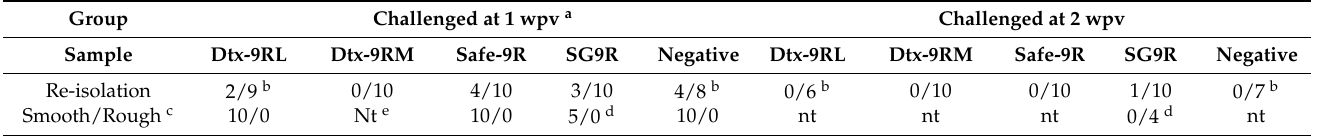
Table 4. Re-isolation and identification of bacteria after live detoxified vaccines inoculation and challenge.